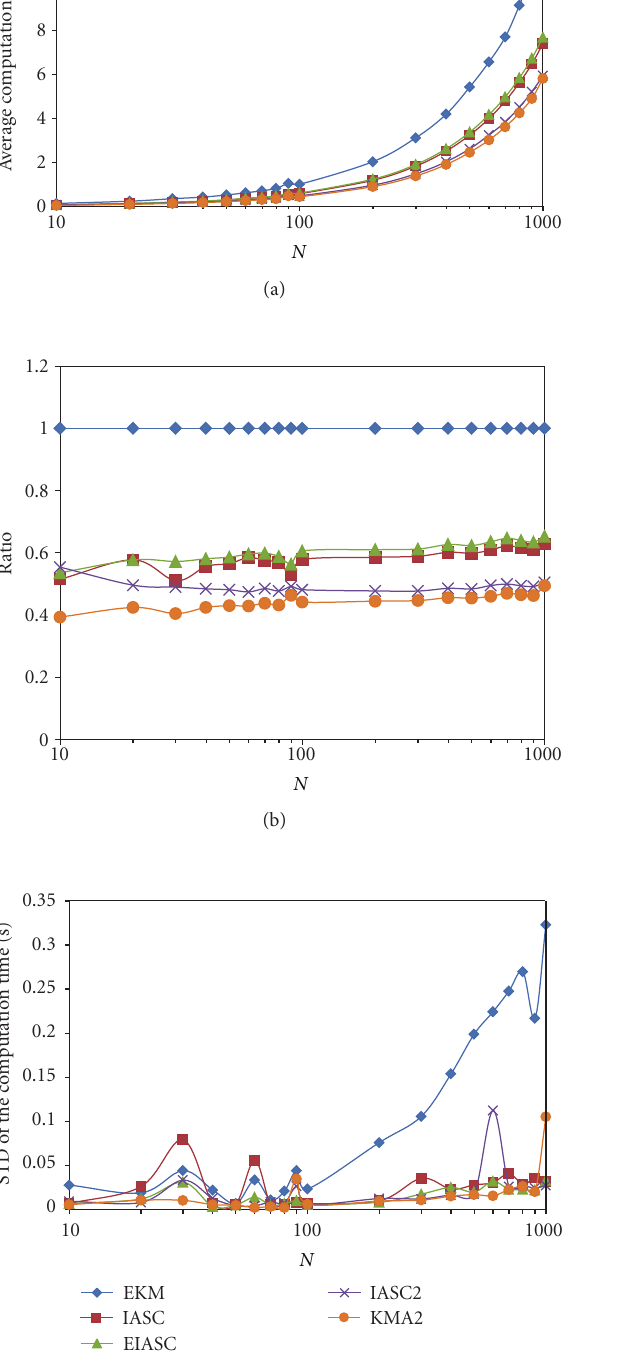
Figure 13: Left-sided random FOU results (interpreted language implementation of the algorithms). (a) Average computation time, (b) ratio with respect to the EKMA, and (c) standard deviation of computation time.